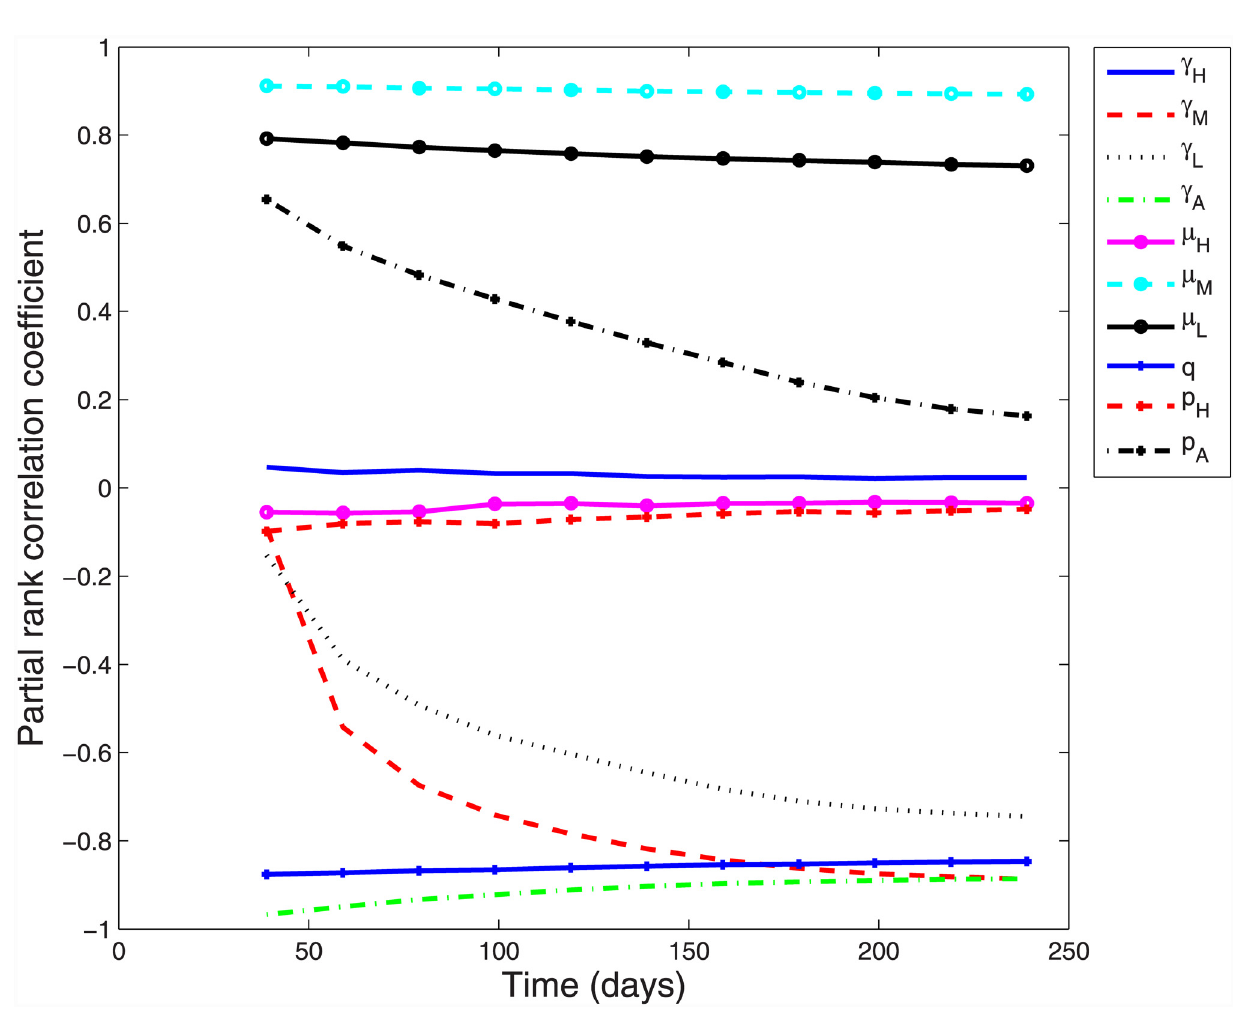
than one for the moderate symptoms group, the reproduction number for the low-level symp- toms group was still the greatest. Decreasing the q parameter (the proportion of symptomatic cases unable to undertake normal duties for two or more days) from 0.76 to 0.42 resulted in decreases in the effective reproduction number for all infection severity strata. The effect of